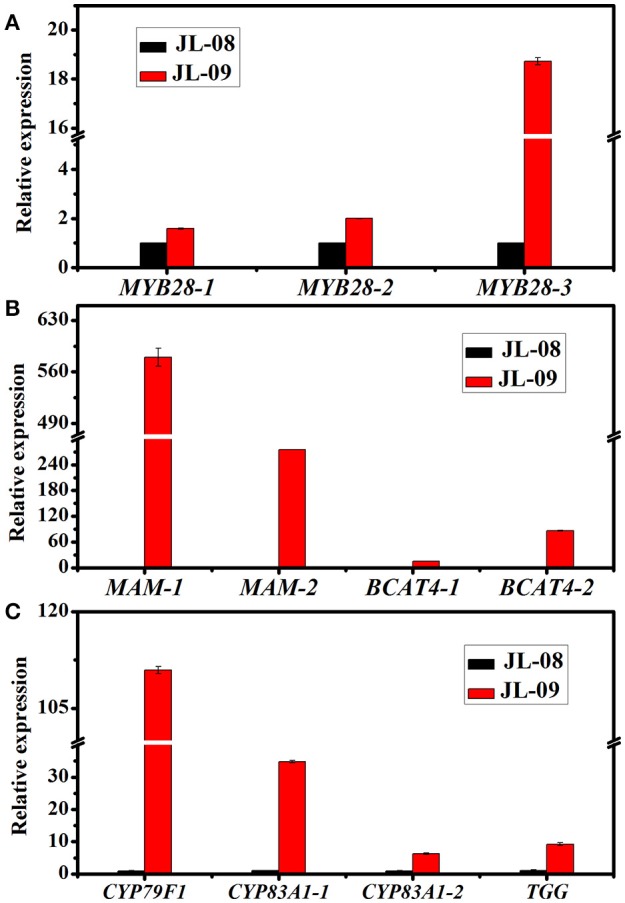
The expression of 11 differently expressed genes in JL-08 and JL-09 sprouts. (A) The expression of transcription factors MYB 28-1, MYB28-2, and MYB28-3. (B) The expression of side chain elongation genes MAM1, MAM3, BCAT4-1, and BCAT4-2. (C) The expression of core structure biosynthetic genes CYP79F1, CYP83A1-1, and CYP83A1-2, as well as degradation gene TGG. The X-axis represented for different glucosinolate biosynthetic genes. The Y-axis is the relative expression of one specific gene to reference gene actin2 and the expression of genes in JL-08 was set to “1” as control. Black column, JL-08; Red column, JL-09.